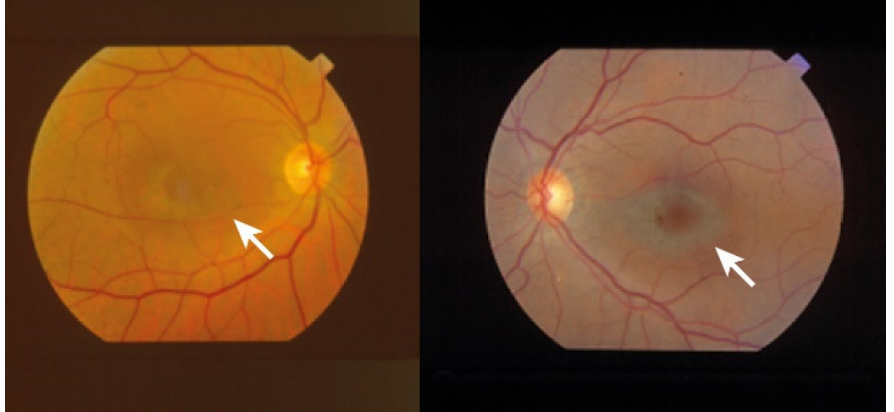
Figure 3. Fundus image: white arrow shows a concentric epithelial degeneration around the fovea, called bull’s eye maculopathy.